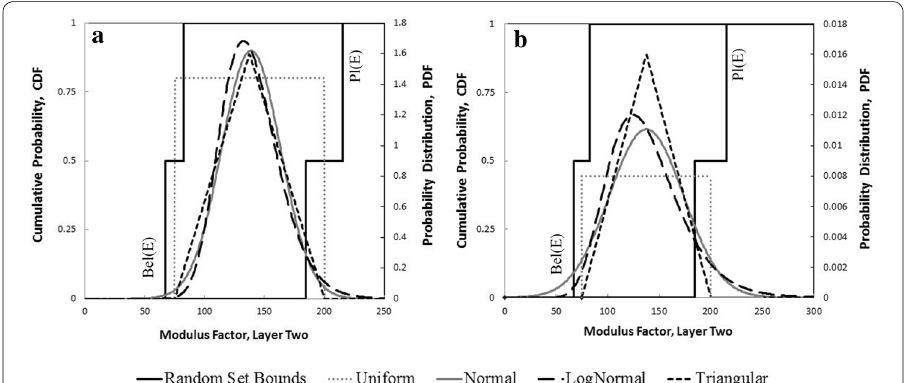
Fig. 5 Distribution of the modulus factor of layer two equivalent to the random set using: a alternative I and b alternative